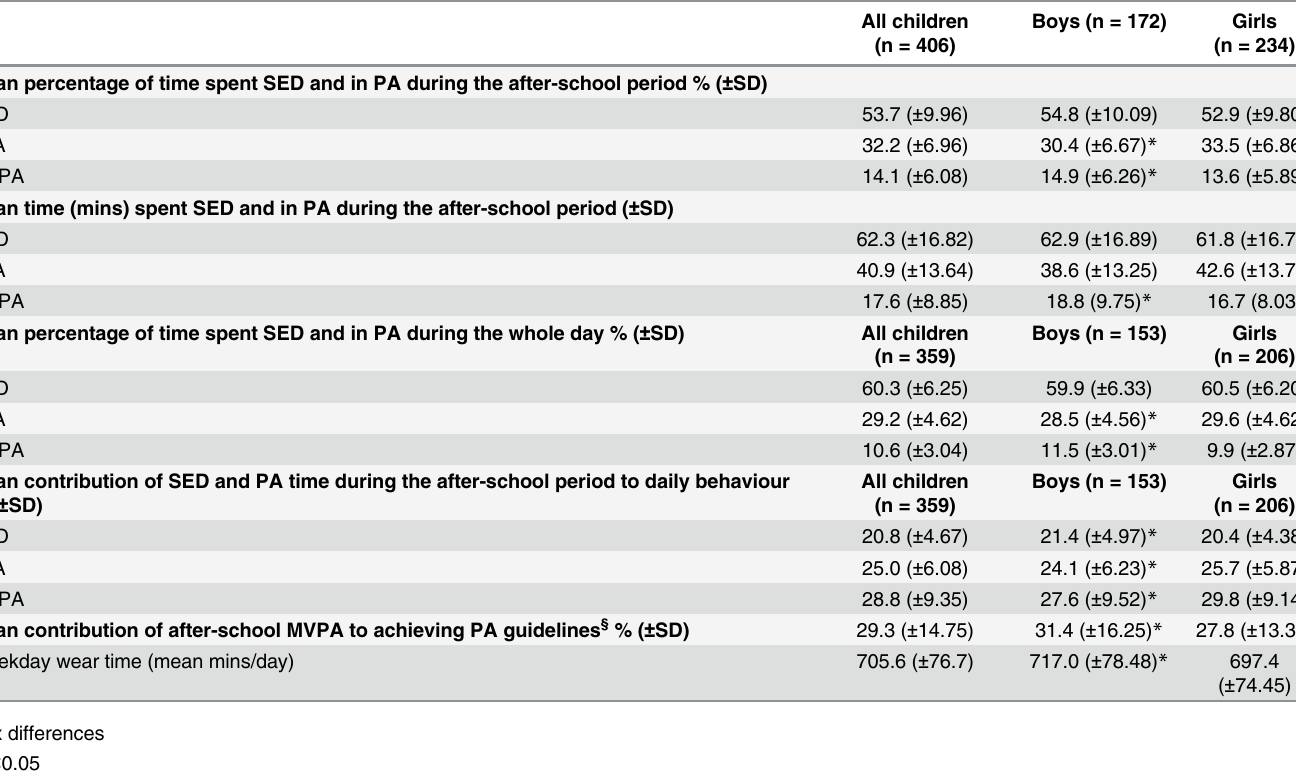
All children (n = 406)